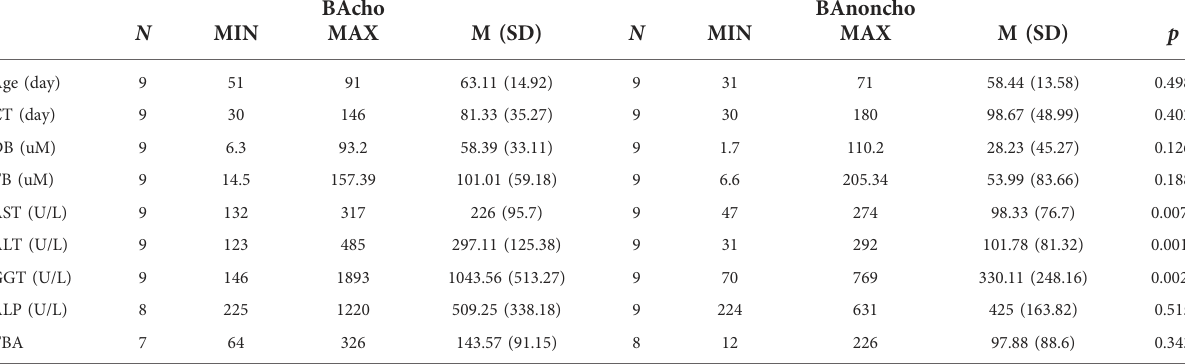
TABLE 1 Biochemical fi gures between BAcho group and BAnoncho